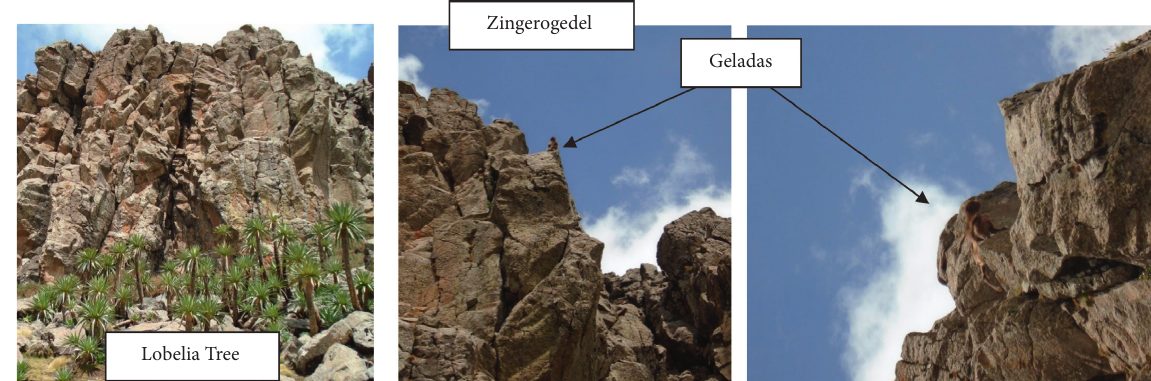
Figure 4: Geladas and gelada habitat inside the protected area (photos captured by the author).